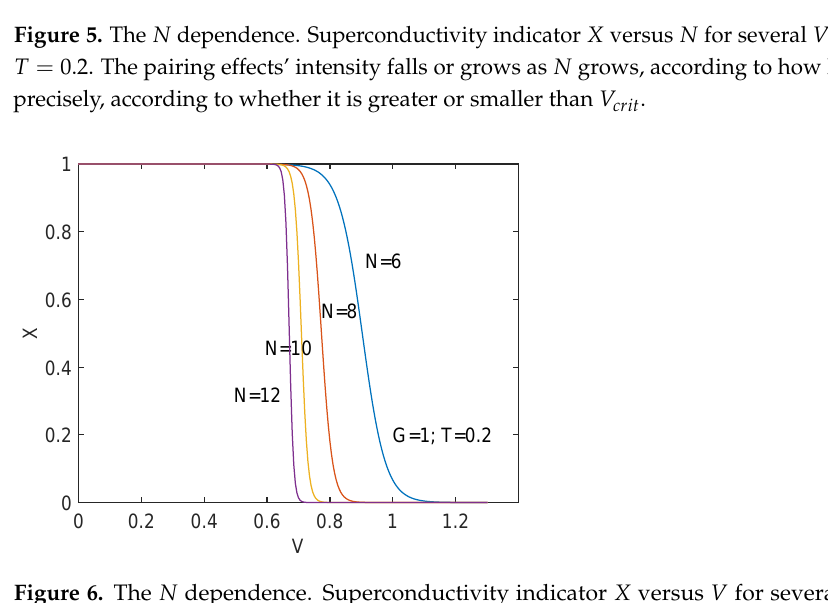
Figure 6. The N dependence. Superconductivity indicator X versus V for several N values. The larger is N , the sooner does V destroy pairing.